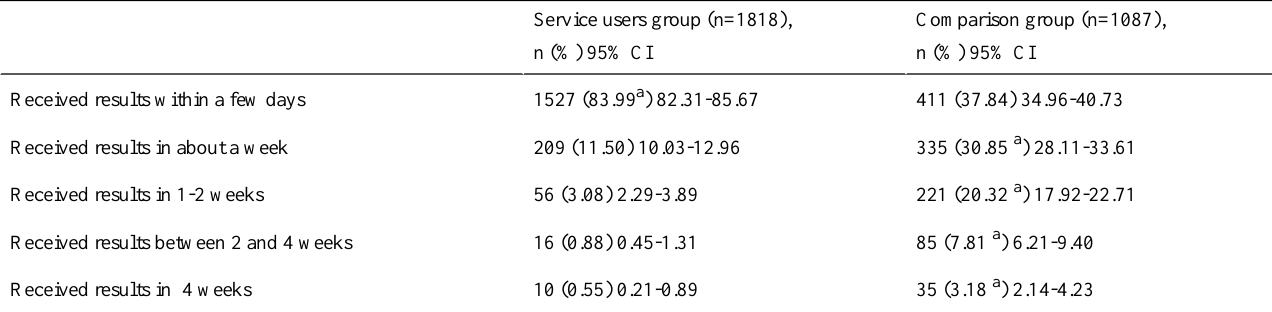
Table 2. Wait time to receive lab results.